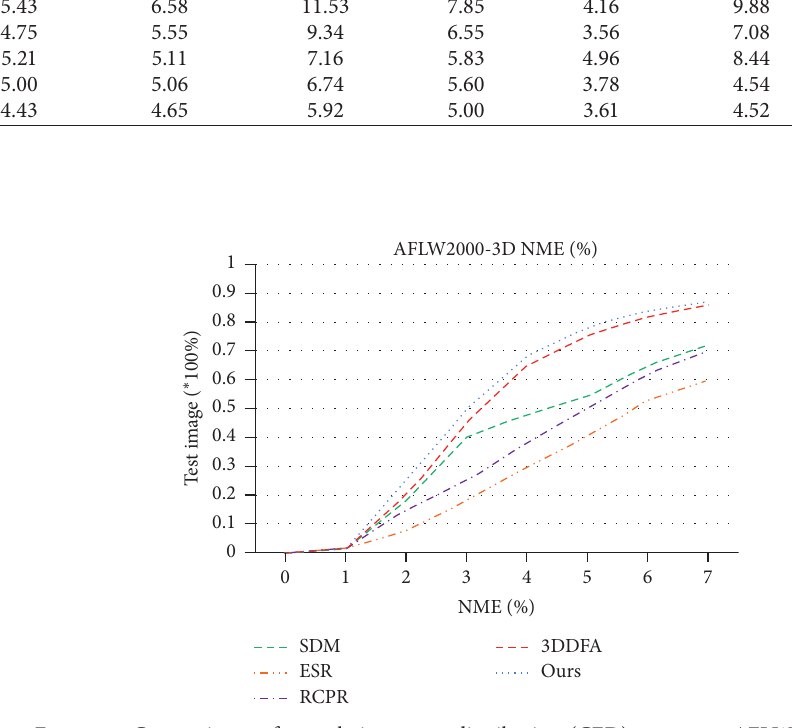
Figure 5: Comparisons of cumulative errors distribution (CED) curves on